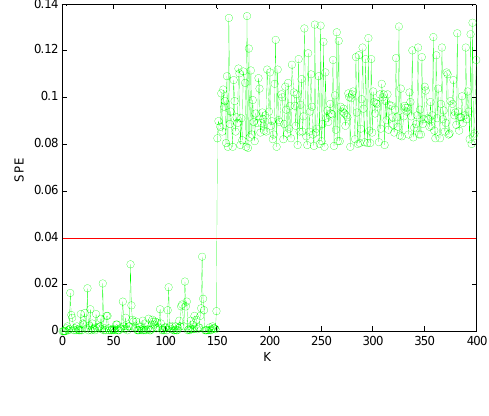
Figure 9. SPE value with sensors 2, 4